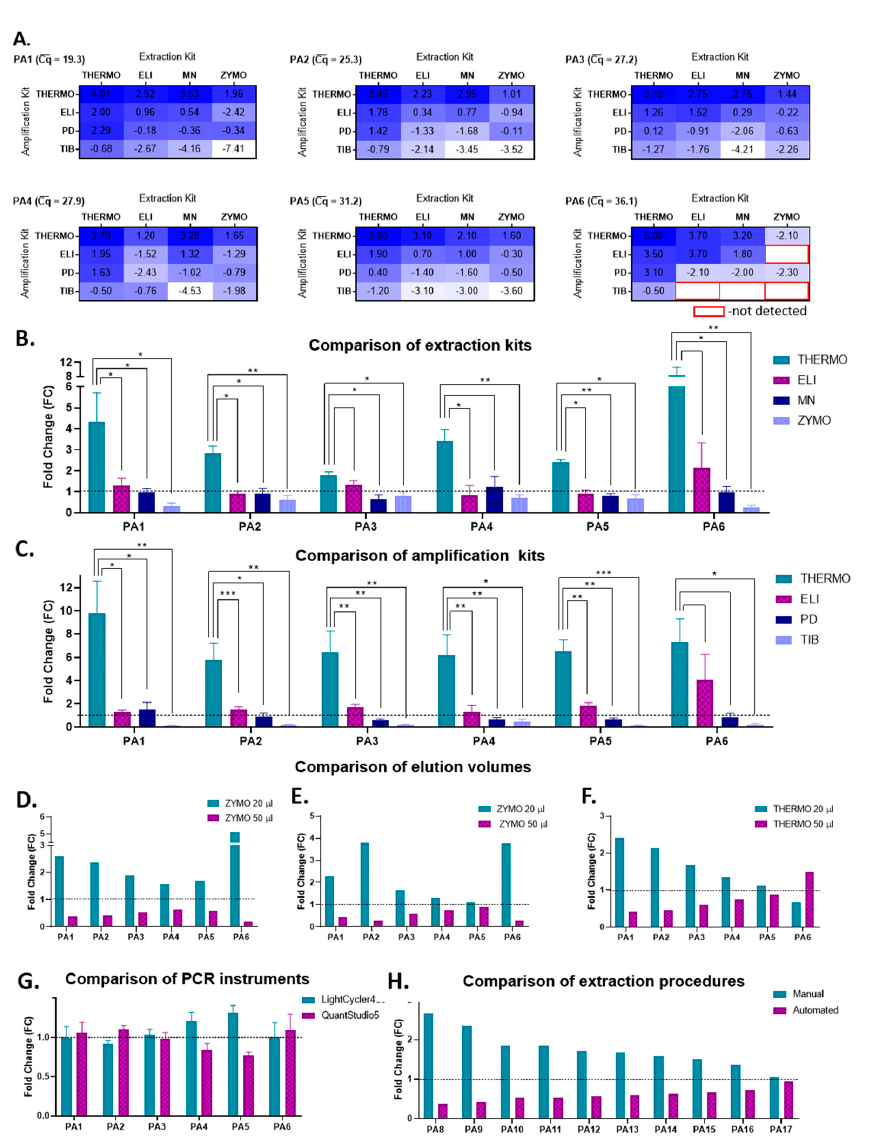
Figure 2. The most efficient combination of extraction and amplification procedures for SARS-CoV-2 detection by RT-qPCR: the relative amplification efficiency for each combination of extraction (THERMO, ELI, MN, and ZYMO) and amplification (THERMO, ELI, PD, and TIB) kits ( A ); the fold change between the extraction kits, without taking into consideration the variances between the amplification kits ( B ); the fold change between the amplification kits, without taking into consideration the variances between the extraction kits ( C ); the fold change between different elution volumes (20 and 50 µ L) used in the extraction procedure, for RNA extracted with ZYMO and amplified with ELI ( D ), for RNA extracted with ZYMO and amplified with THERMO ( E ), and for RNA extracted with THERMO and amplified with THERMO ( F ); the fold change between the different RT-qPCR instruments (LightCycler480 and QuantStudio5) for RNA extracted with all four extraction kits (THERMO, ELI, MN, ZYMO) and amplified with ELI, without taking into consideration the variances between the extraction kits ( G ); the fold change between manual (extraction kit: THERMO; elution volume: 20 µ L; amplification kit: THERMO) and automated (NeuMoDx) procedures ( H ). The biological samples used for the data presented in ( A – G ) were collected from the same six COVID-19-positive patients (PA1–6), whereas samples used for the data presented in ( H ) were collected from 10 other COVID-19-positive patients (PA8-17). Data in ( B , C , G ) are presented as mean ± SEM, whereas the statistical significance was assessed by a paired t -test ( p * < 0.05, p ** < 0.01, p *** < 0.001). PA—patient; Cq —average quantification